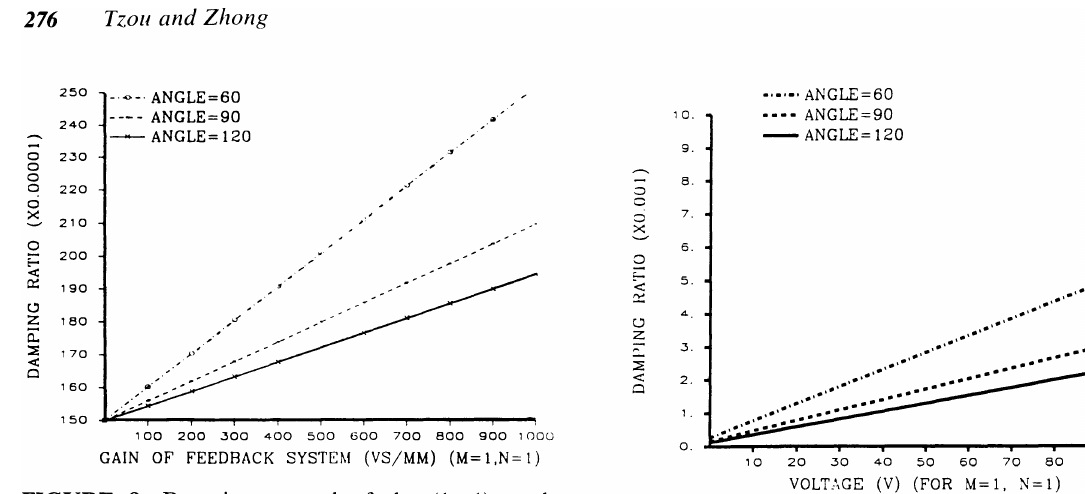
FIGURE 8 Damping control of the (1, 1) mode (i-mm shell, 40-,um actuator).